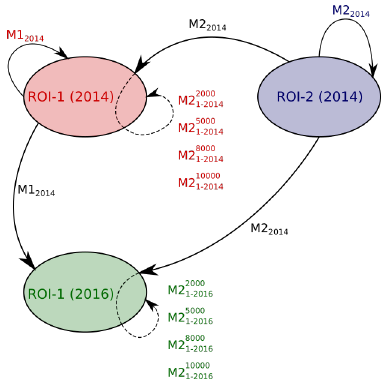
Figure 4. Experiments during training with both methods described in Section 3 (dotted lines: FTNs on the new area) ROI-1(2014), ROI-1(2016), ROI-2(2014) stand for the Spot images acquired on Brest in 2014/2016 and Le Faou in